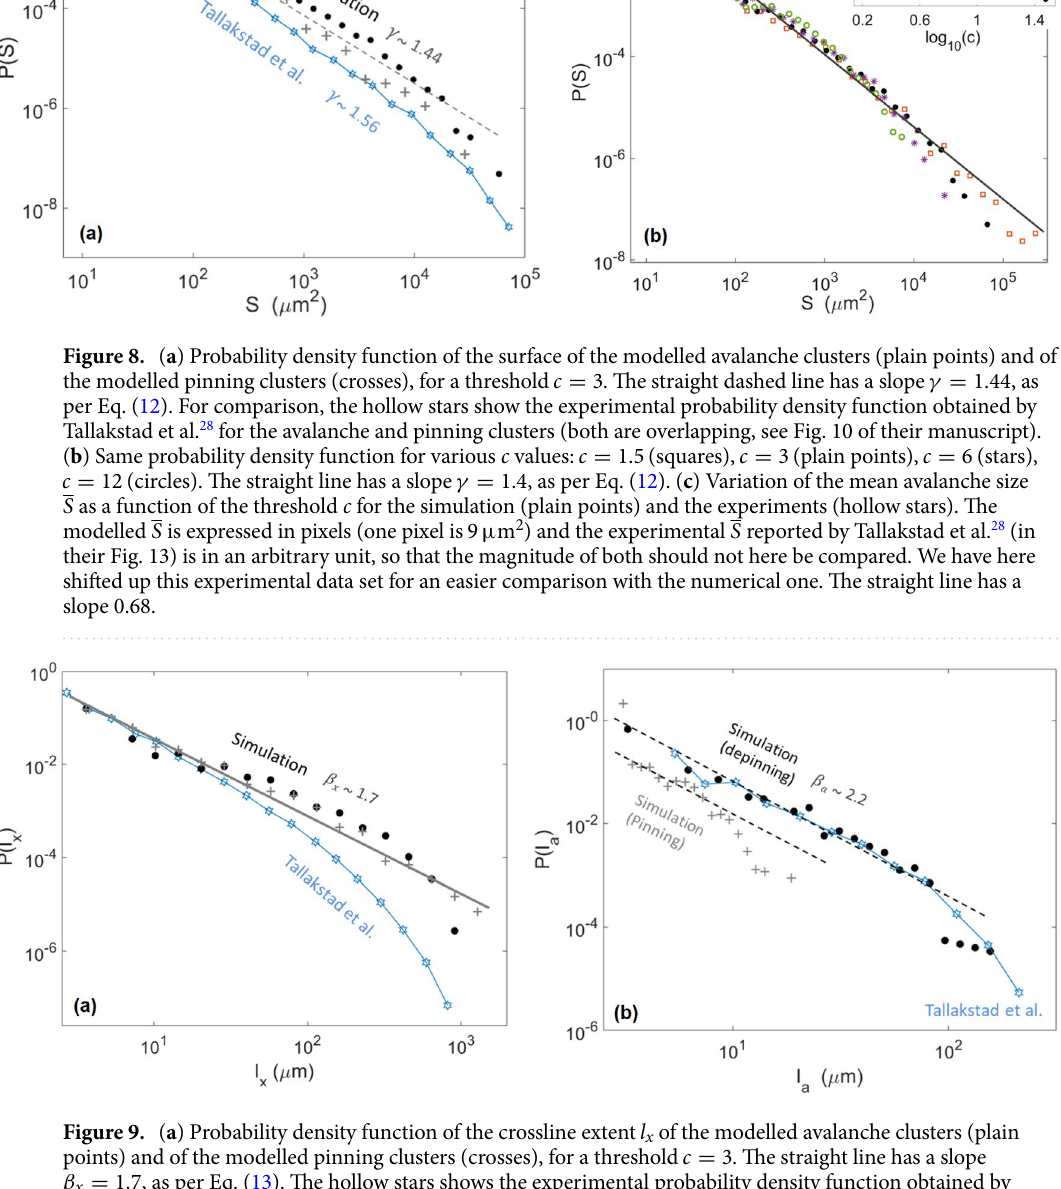
We also computed the probability density function of l x and l a , that are respectively compared to their experi- mental equivalent in Fig. 9. These functions can be fitted with